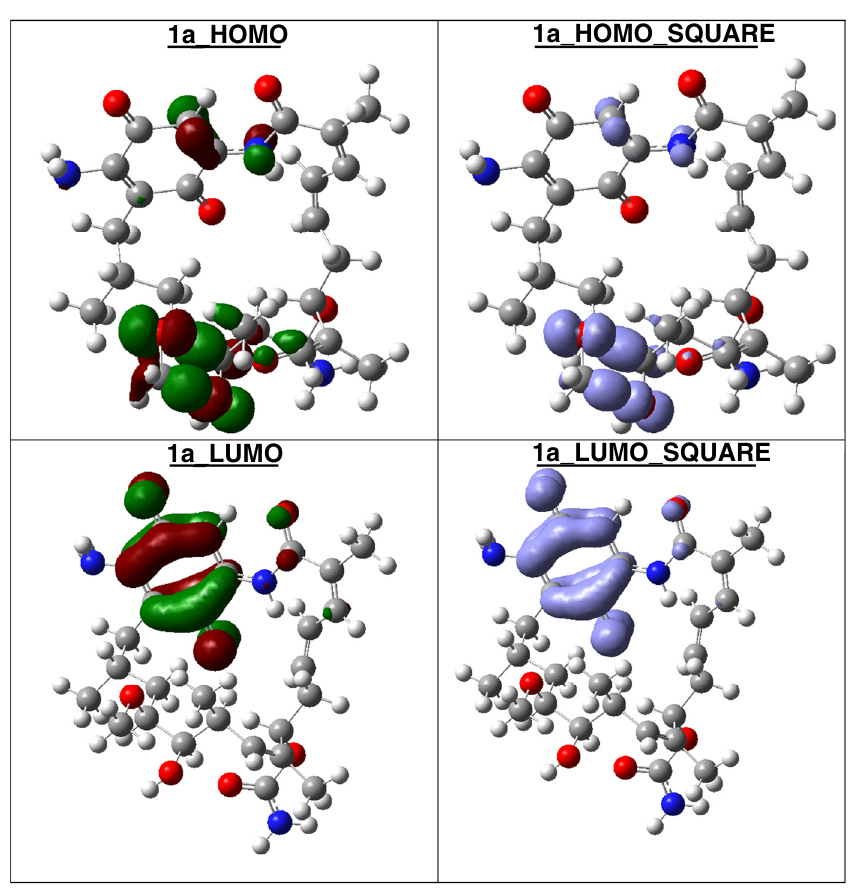
Figure 17. Frontier molecular orbitals HOMO, LUMO (isosurface 0.02), the Fukui